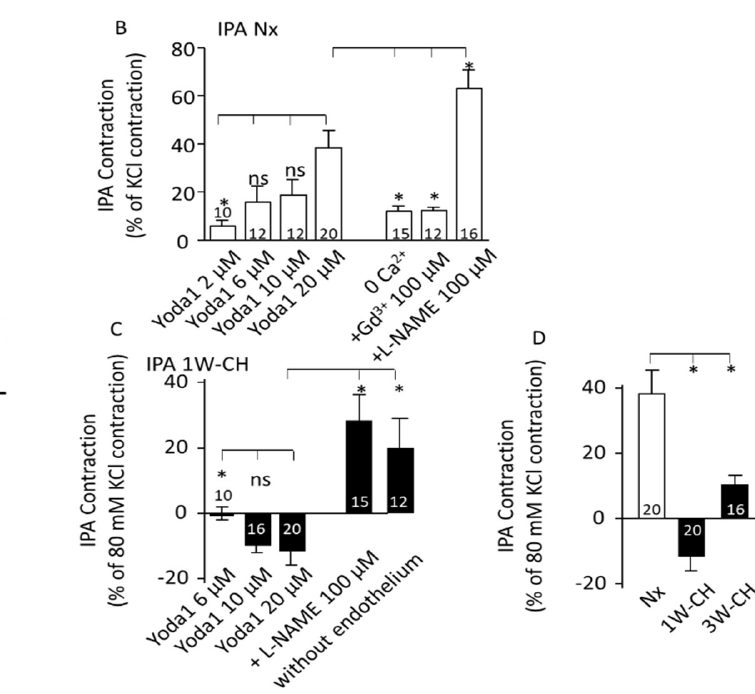
Figure 3. Piezo1 activation changes vascular tone response in IPA. Piezo1 contracted Nx IPA, but relaxed 1W-CH IPA. ( A ) A typical trace of IPA tension was recorded in the presence of Yoda1 in Nx ( A1 ), 1W-CH ( A2 , A3 ), and 3W-CH ( A4 ) conditions. For 1W-CH, two types of responses could be observed: a relaxation ( A2 ) or a contraction ( A3 ). In ( A3 ), the application of carbachol (endothelial M3 agonist) induces a relaxation showing a functional endothelium. ( B ) Statistical analysis of the contraction induced by Yoda1 (2–20 µ M) in Nx IPA. The Yoda1 (20 µ M)-induced contraction was inhibited, in absence of extracellular calcium (0 Ca 2+ ), by GdCl3 (Gd 3+ , 100 µ M) and amplified in the presence of L-NAME (100 µ M). ( C ) Amplitude of the Yoda1-mediated relaxation in 1W-CH. In the presence of L-NAME (100 µ M) or mechanical abrasion of the endothelium, the relaxation induced by 20 µ M Yoda1 was reversed to a contraction. ( D ) Comparison of the effect of 20 µ M Yoda1 in Nx, 1W-CH, or 3W-CH IPA. * p < 0.05. The number inserted in the bar graph represented the number of arterial rings analyzed. The vertical arrow represents the beginning of the drug’s application. ns=not significant. A minimum of four different rats, at least four rings per rat were